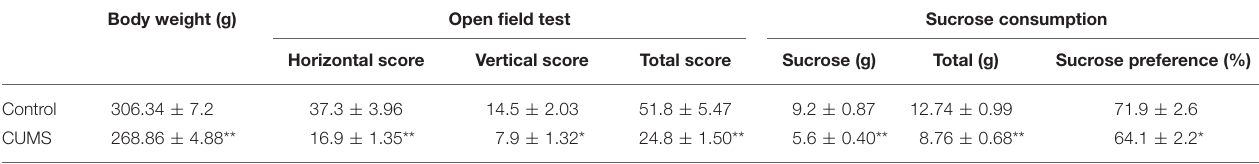
TABLE 1 | The body weight, open-field test and sucrose consumption test in the two groups rats after modeling ( n = 20, mean ± SEM). Body weight